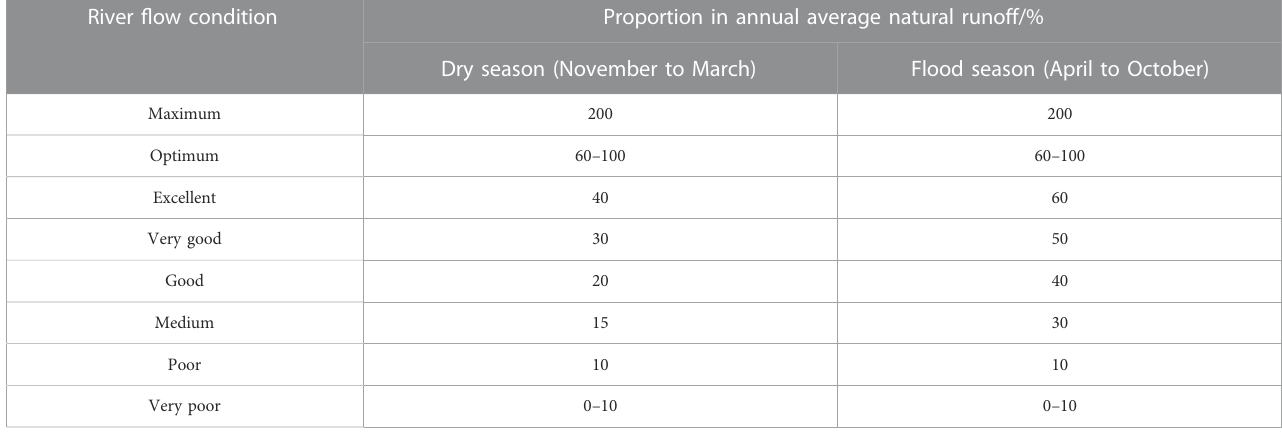
TABLE 1 Ecological base fl ow criteria recommended by the Tennant